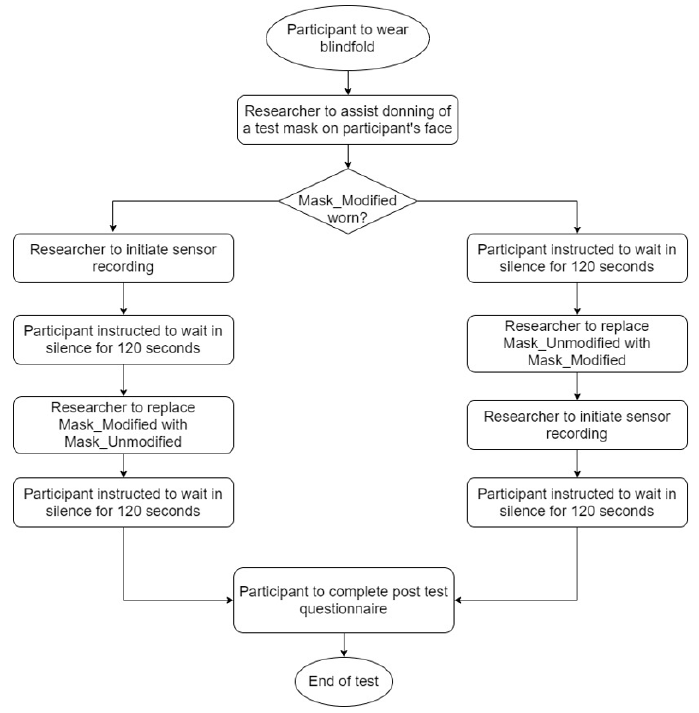
Figure 2. Usability test procedure.